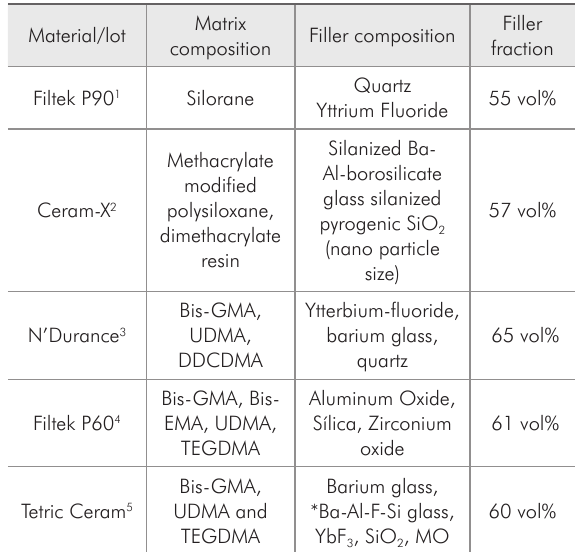
Table 1 - Dental composites used in the current study (com- position as stated by the